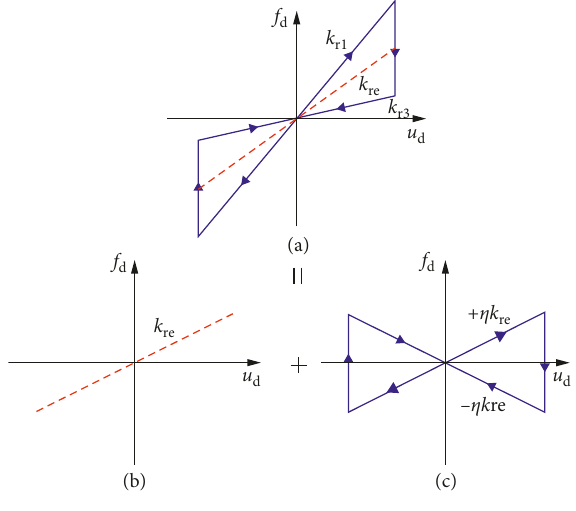
Figure 1: Reid hysteretic